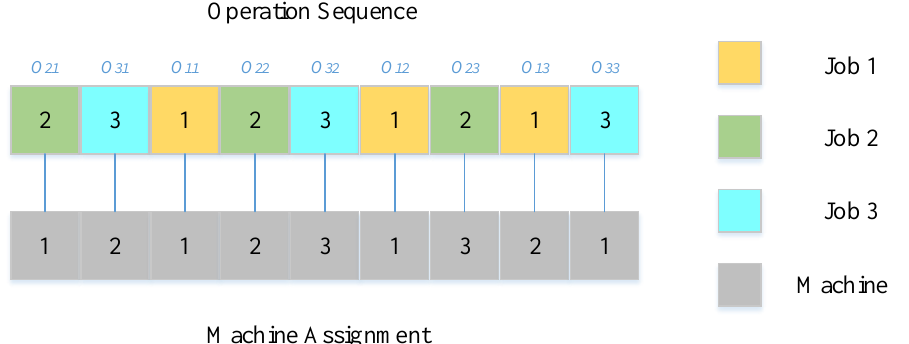
Figure 2. The coded representation of Figure